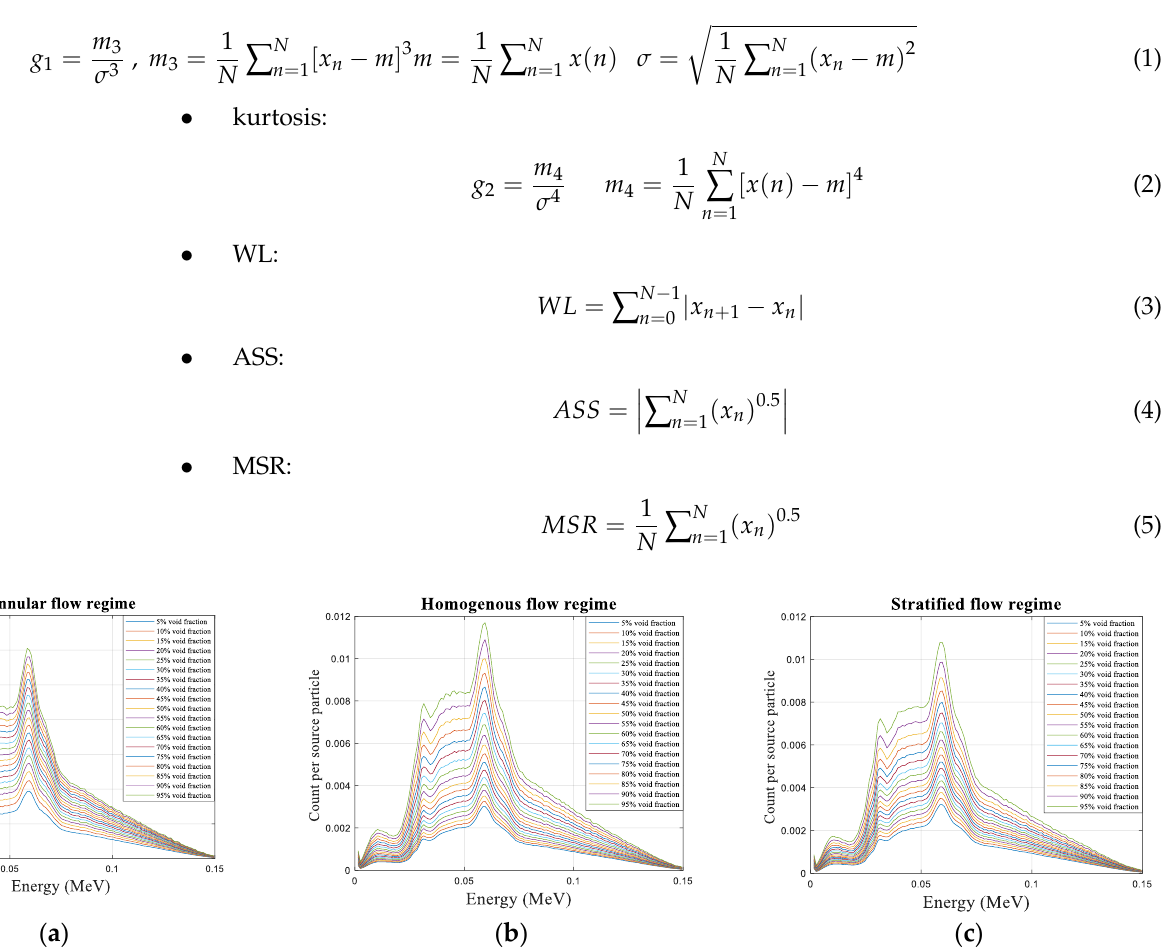
Figure 5. Received signals from the NaI detector for three flow regimes of ( a ) annular, ( b ) homoge- neous, and ( c ) stratified.